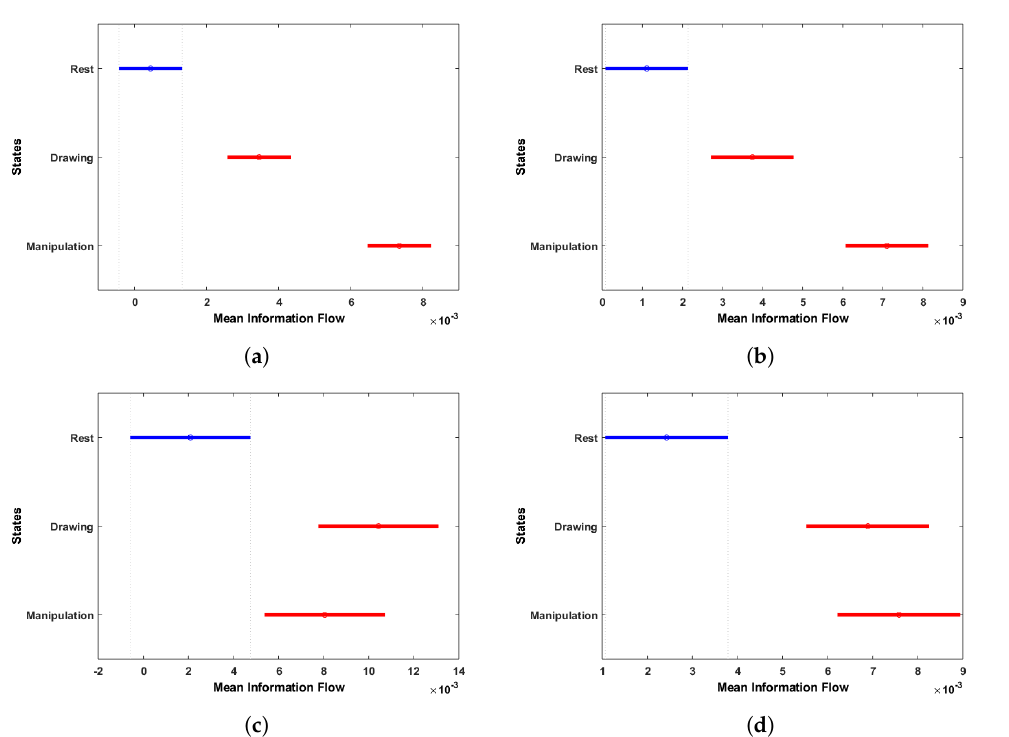
Figure 14. Multi-comparison of ANOVA on mean information flow of each electrode to all other electrodes during rest, drawing and manipulation states. ( a ) User 3 (Novice). ( b ) User 6 (Novice). ( c ) User 7 (Expert). ( d ) User 8